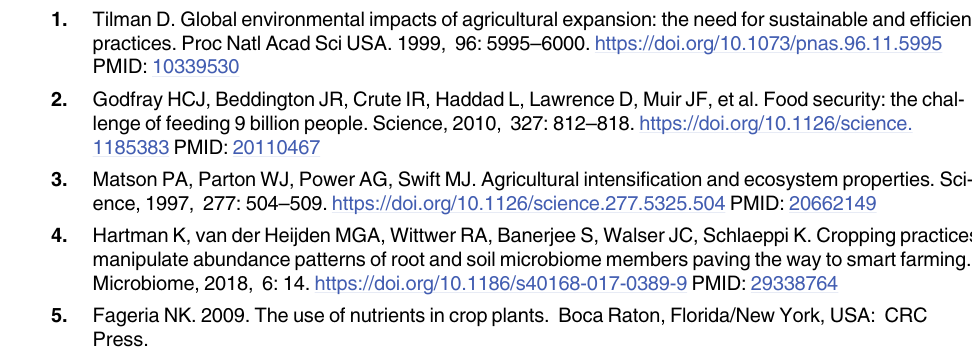
S1 Fig. Classification of OTU4. Taxonomic tree of OTU4 built by maximum likelihood method including 10 more 16S rRNA sequences (GQ360077.1) of type Bacillus species and matched segment (CP0068901.1) from the whole genome of strain SQR9. a, taxonomic tree; b, matched segment from the whole genome and 16S rRNA sequence of strain